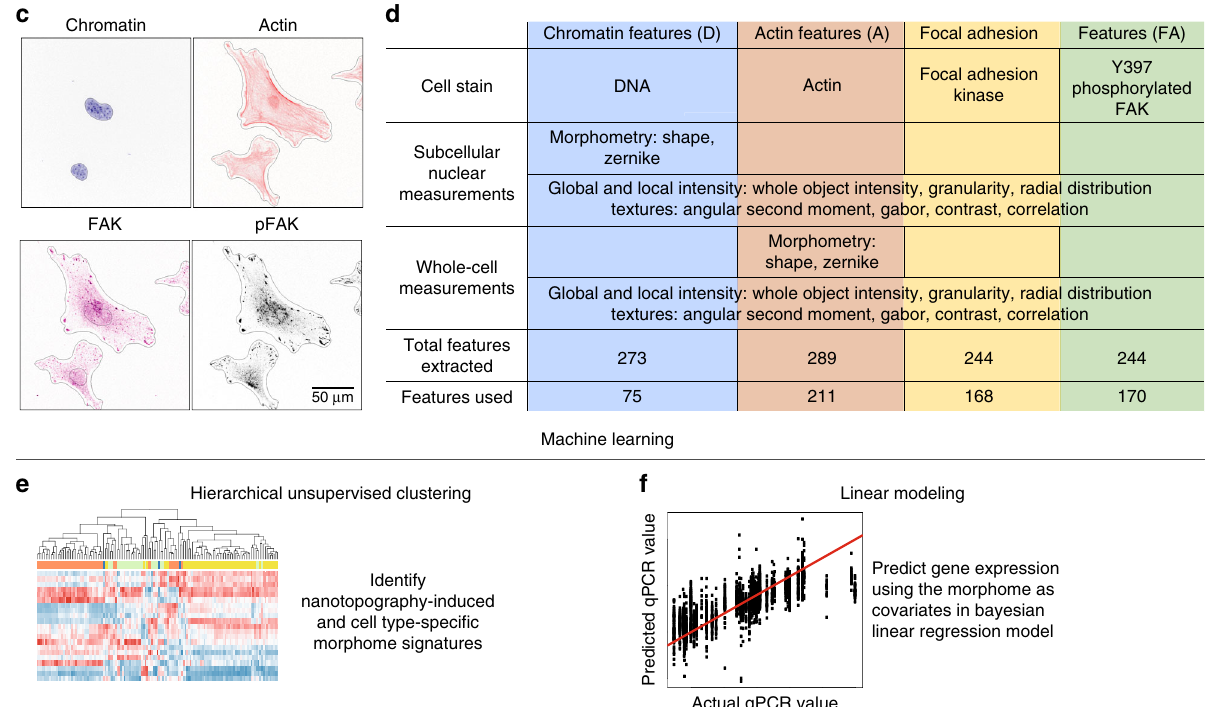
lineage marker MYOD1 , and of the late markers MYOG and MYH7 when cultured on SQ surfaces relative to FLAT surfaces (Fig. 3a, b). This myogenic gene expression pro fi le was similar to pre-myoblasts stimulated with biochemical inducers of myogenic differentiation for 4 days (see Supplementary Fig. 6a, e). Both pre- osteoblasts and osteoblasts showed increased expression of early